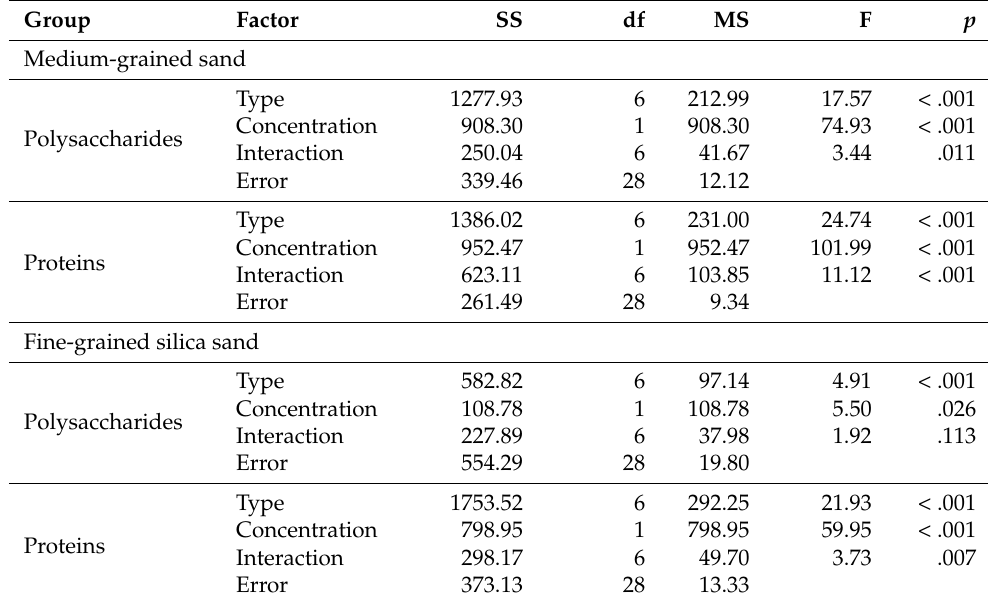
Table 4. Results of two-way ANOVA ( α = .05) of maximum penetration resistance measured by